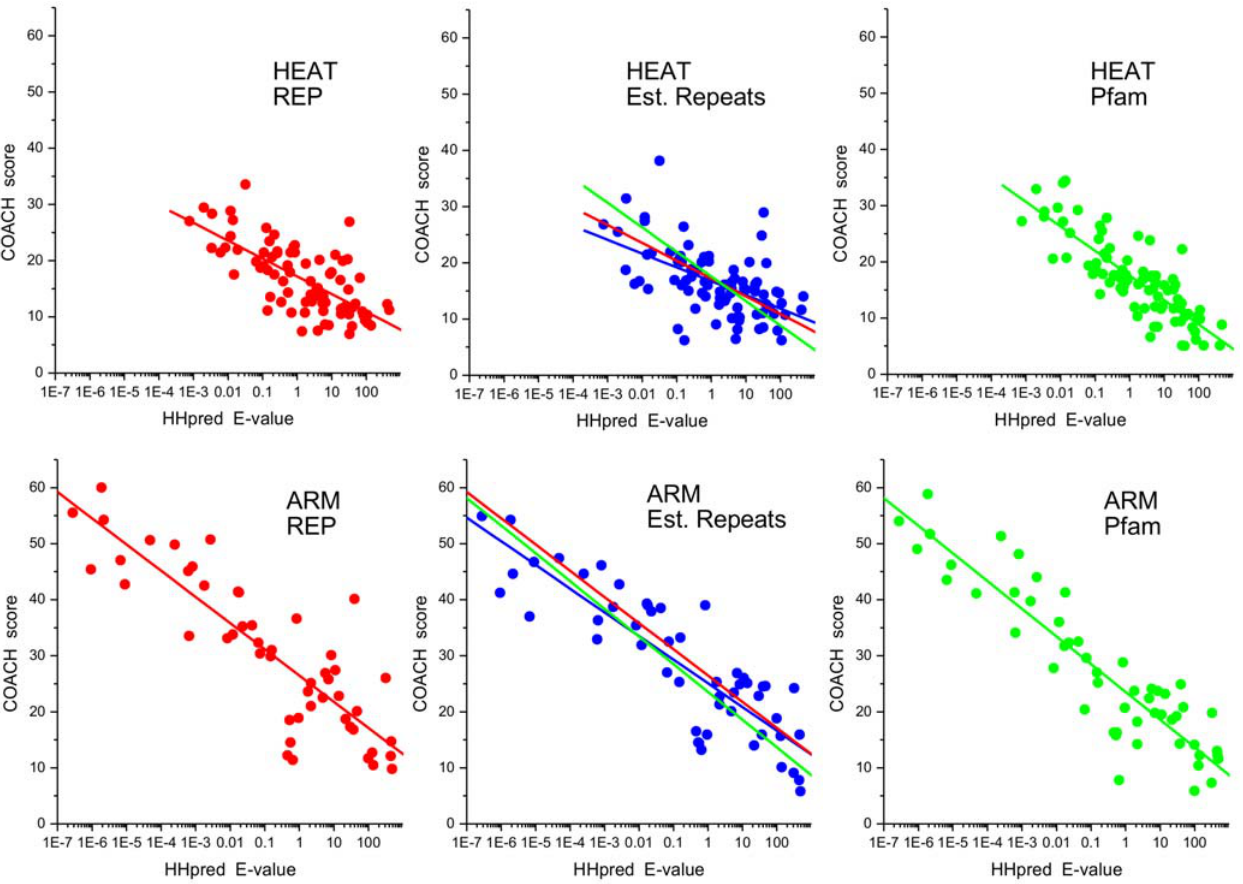
Figure 6. Correlation between HHpred E-values and COACH scores. HHpred and COACH results for identified repeats from the HEAT (top) and ARM (bottom) structures as specified in Fig. 3. Only repeats with HHpred E-values , 500 and COACH scores . 5 are included. The reference data sets for COACH analysis were: REP (left), Established Repeats (middle) and Pfam (right). Linear regressions are shown (all p , 0.001); for comparison, the regressions for the REP (red) and Pfam (green) reference sets are also displayed in the middle panels.